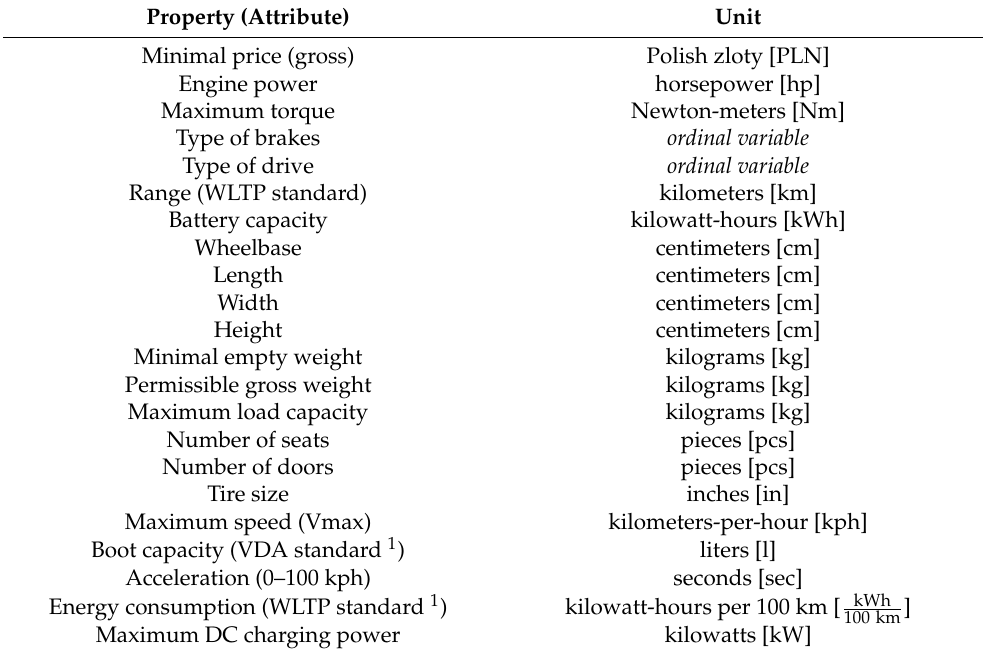
Table 1. Variables used in market segmentation to describe the given electric cars’